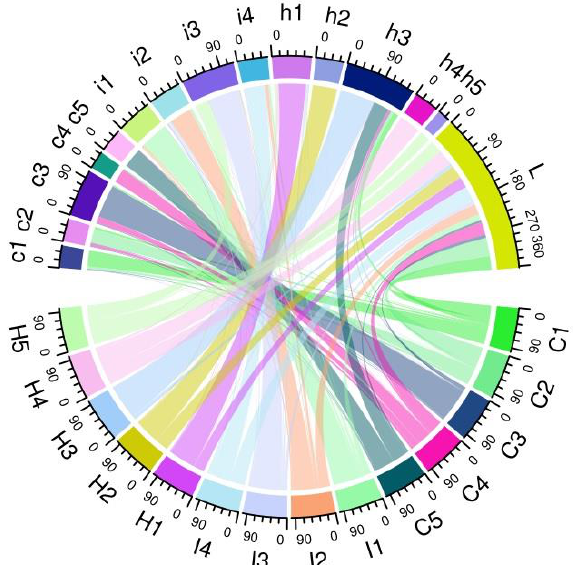
Figure 4. The interchange between different types of wetlands from 1990 (uppercase letters) to